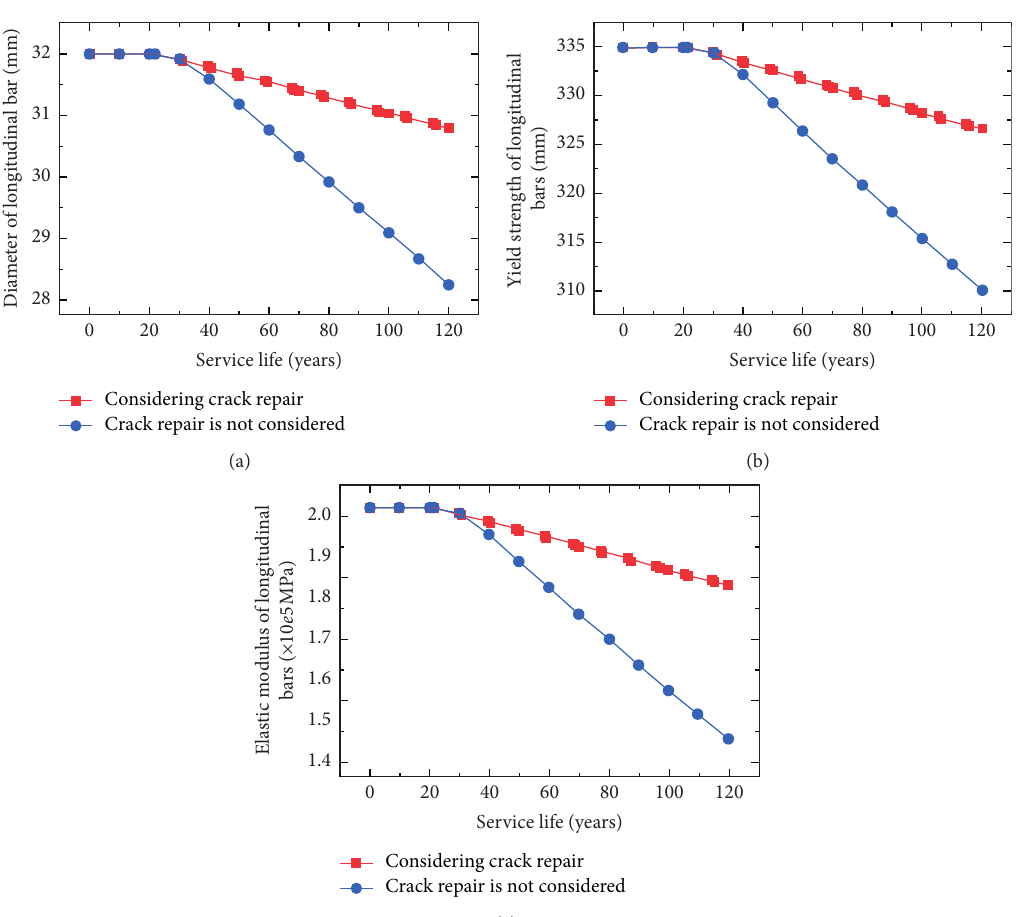
Figure 9: Change in longitudinal steel characteristics: (a) change in diameter; (b) change in yield strength; (c) change in elasticity